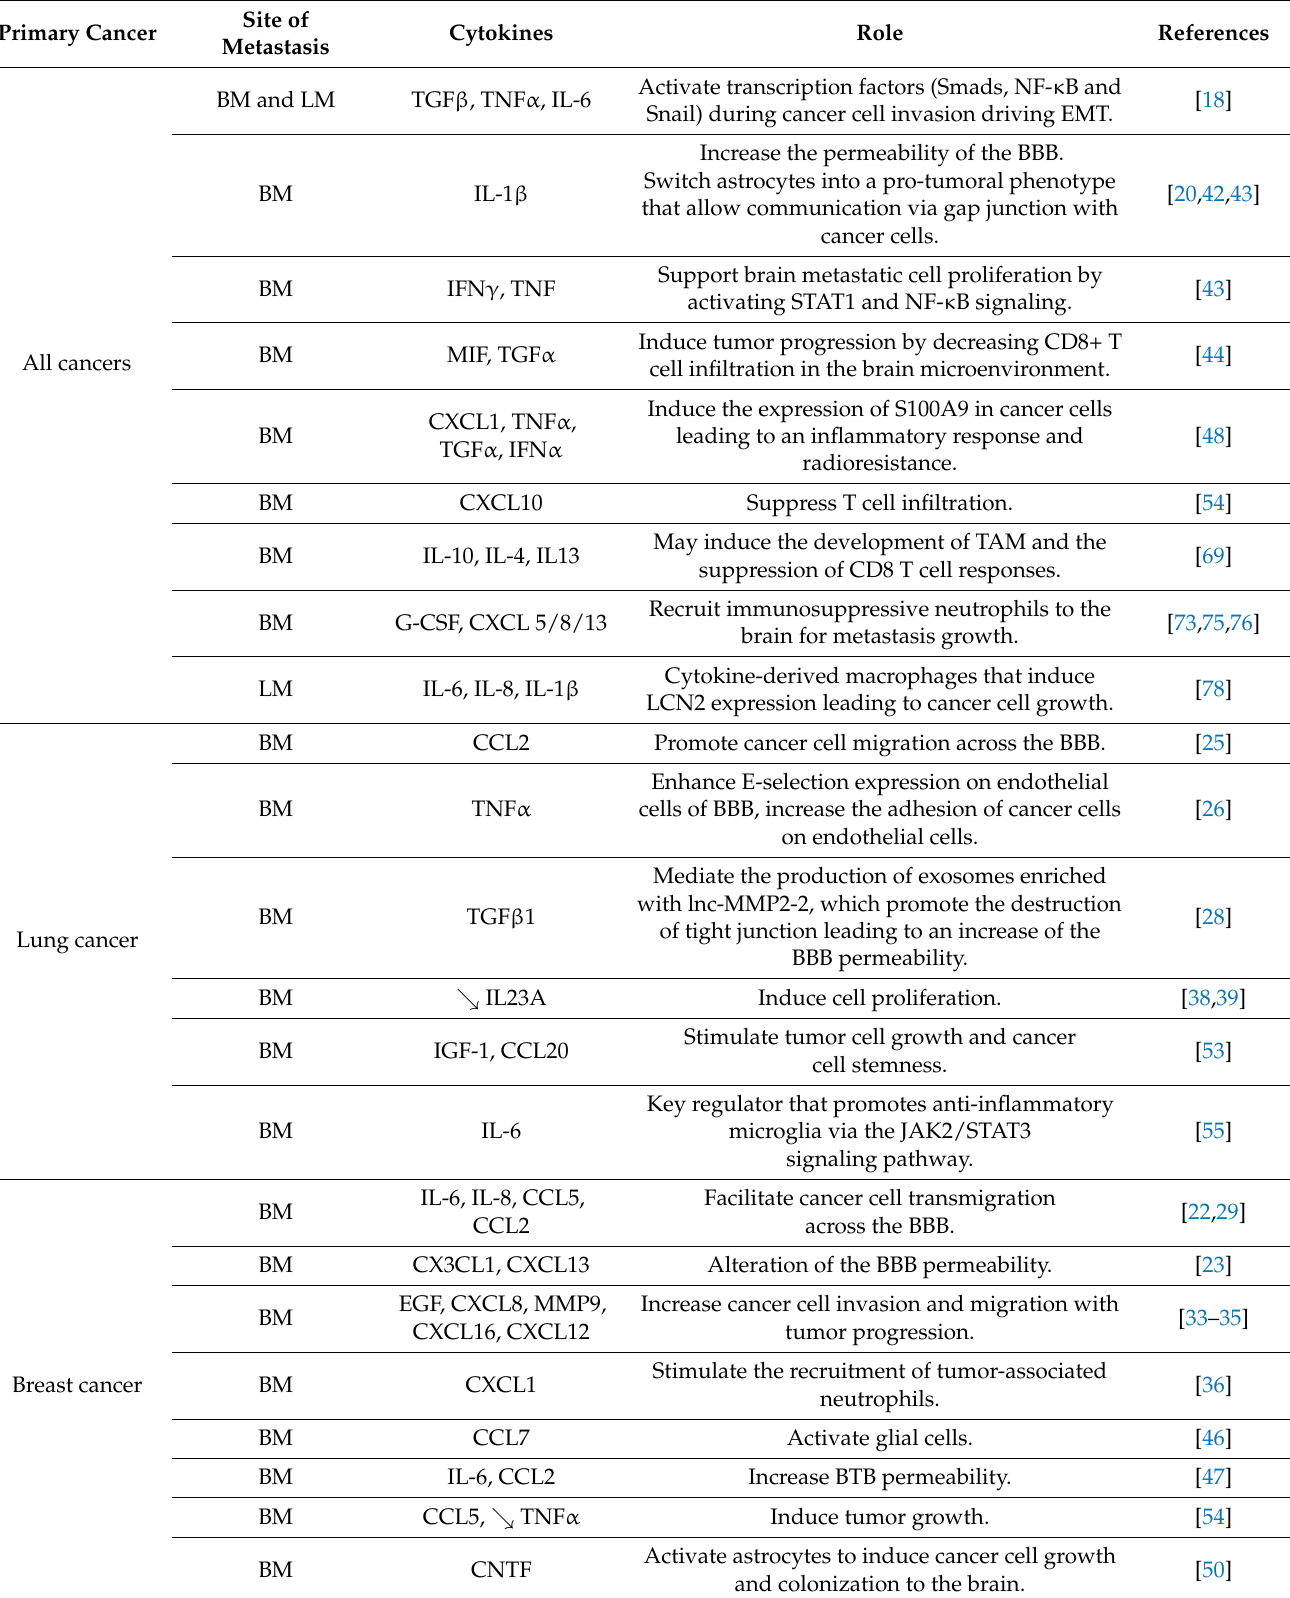
Table 2. Cytokines and chemokines involved in BM and LP development and